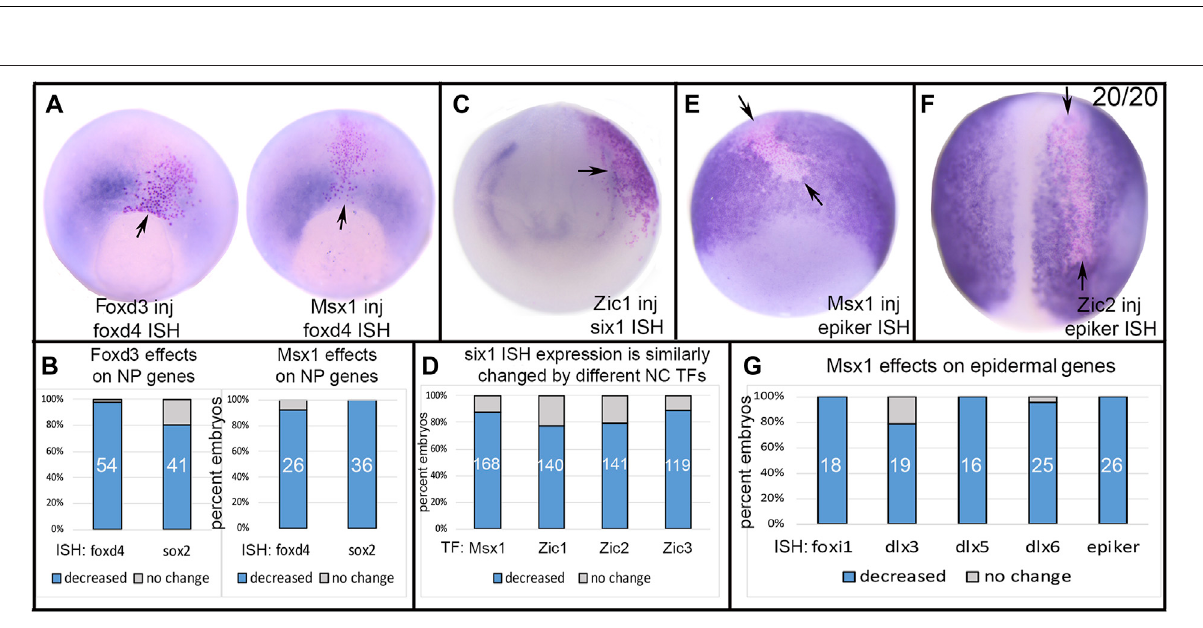
cells expressing at least two ( Tables 3 , 5 ) or more ( Tables 4 , 6 , 7 ) transcription factors. In each table, the number of cells that expressed both the selected transcription factor (each column) and one of the other eight analyzed genes (each row) was tabulated. The bottom row of Tables 3 , 5 denotes the number